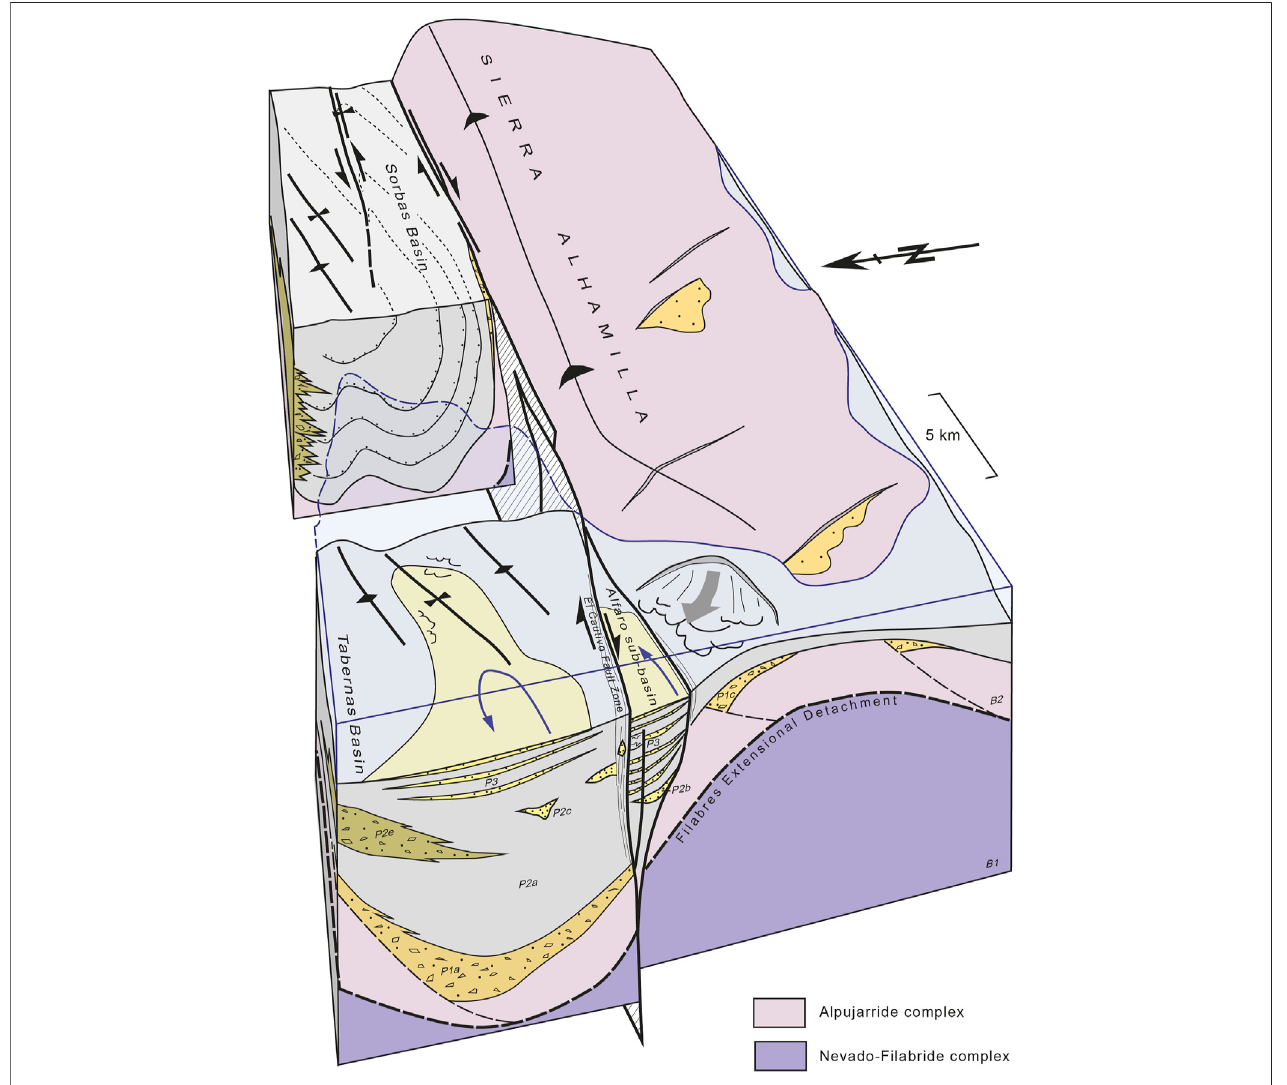
FIGURE 15 | Cartoon summarising the structural con fi guration of basins north of the Sierra Alhamilla basement block in the latest Tortonian. Sorbas Basin was being inverted in dextral transpression at the same timethat dextral transtension drove opening of a narrow sub-basin in the Tabernas area. Subsidence in the area was initially driven by early (Serravalian) SW-directed extension (Martínez-Martínez and Azañón, 1997; Martínez-Martínez and Azañón, 2002) followed by strike-slip deformation and then regional buckling that differentially uplifted basement blocks fl anking the basins. See caption to Figure 2 for key to Tabernas basin fi ll